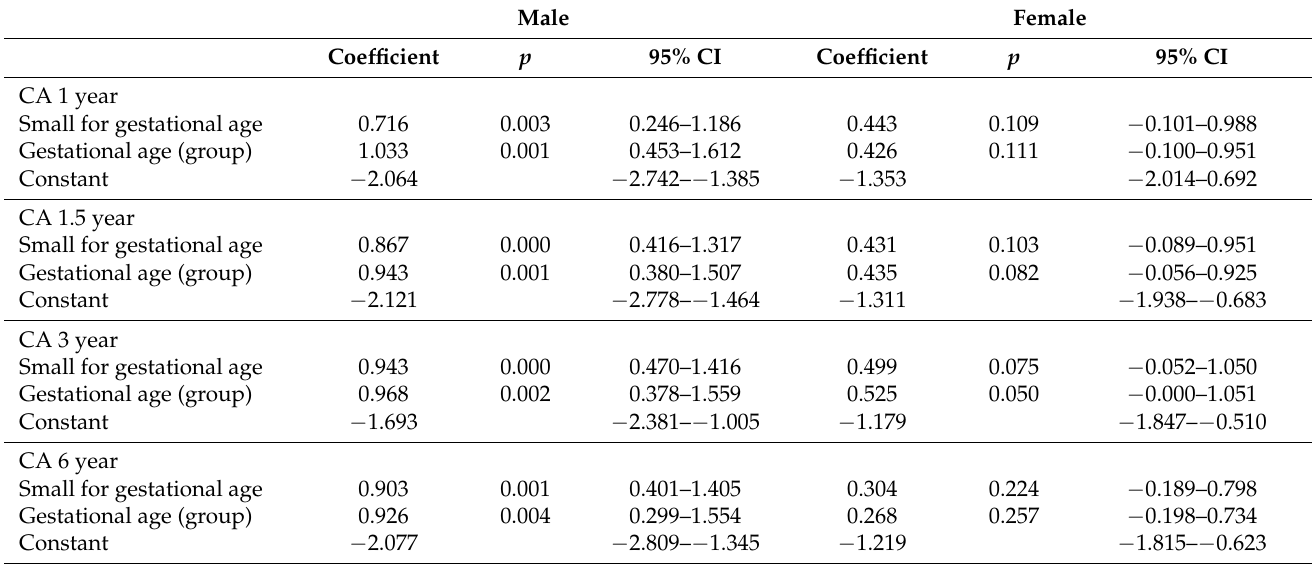
Table 4. Linear regression analysis to determine the association between body mass index z-scores and the presence of small for gestational age and two gestational age